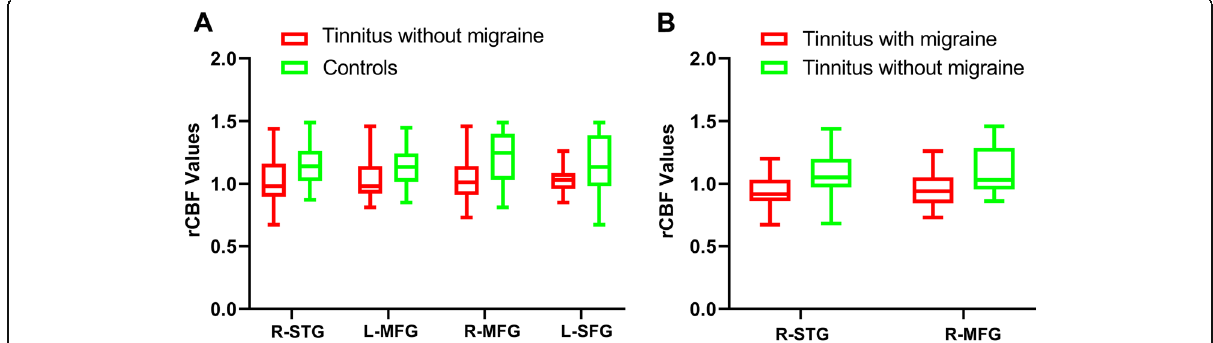
Fig. 3 The rCBF values for different groups. ( A ) The rCBF values of the chronic tinnitus patients without migraine and non-tinnitus controls in the right STG, left MFG, right MFG, and left SFG ( P < 0.01). ( B ) The interaction effect of migraine on tinnitus in the right STG and right MFG ( P <